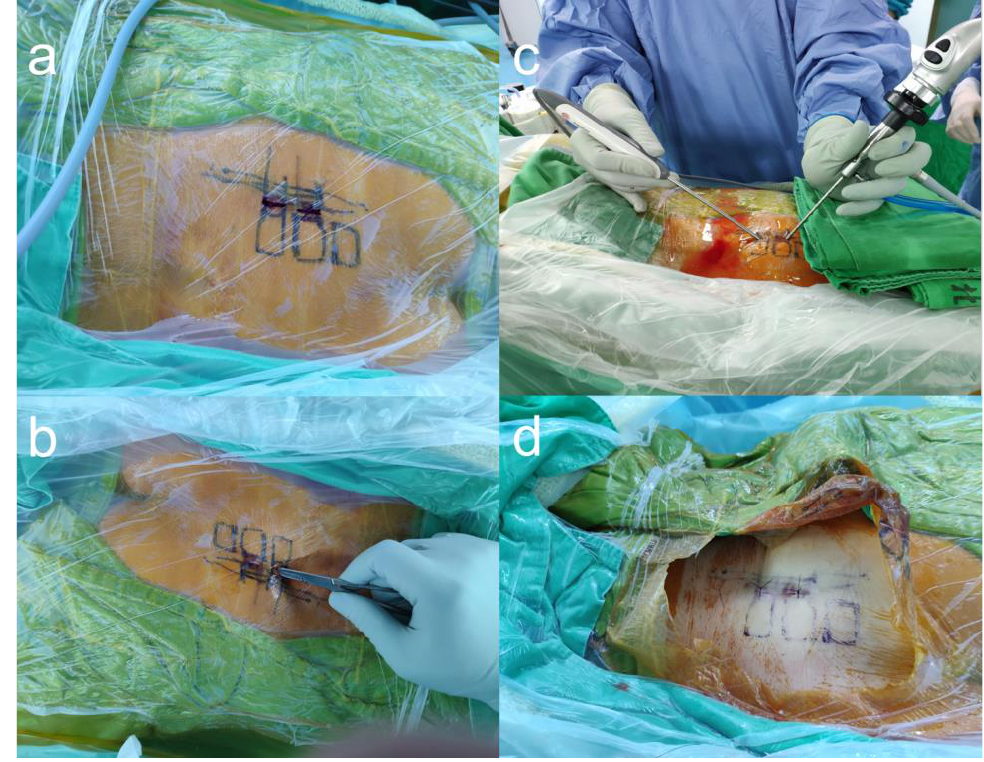
Figure 1. The entry points and working channels of biportal endoscopic radiofrequency ablation. ( a ) Under fluoroscope, the S1 – S3 foramina were marked on the skin. ( b ) Two incisions were made, one near the S1 foramen and another near the S2 foramen. ( c ) One foramen was for the endoscopic channel, and the other was for the insertion of the ablation wand. ( d ) Sutured wound after the surgery. We injected 3 cc of local anesthetic with 1% lidocaine hydrochloride at each entry point and 5 cc of lidocaine to infiltrate into the space between S1 and S2 area. Subsequently, two 0.5 cm skin incisions were made at the entry points. A pair of Kelly forceps was used in each of the incisions, and a blunt supported the space between the erector spinae muscles (multifidus and longissimus muscles) and interosseous ligament overlying the posterior SIJ. After the insertion of the cannula, we introduced a 30 ◦ endoscope with a 4 mm